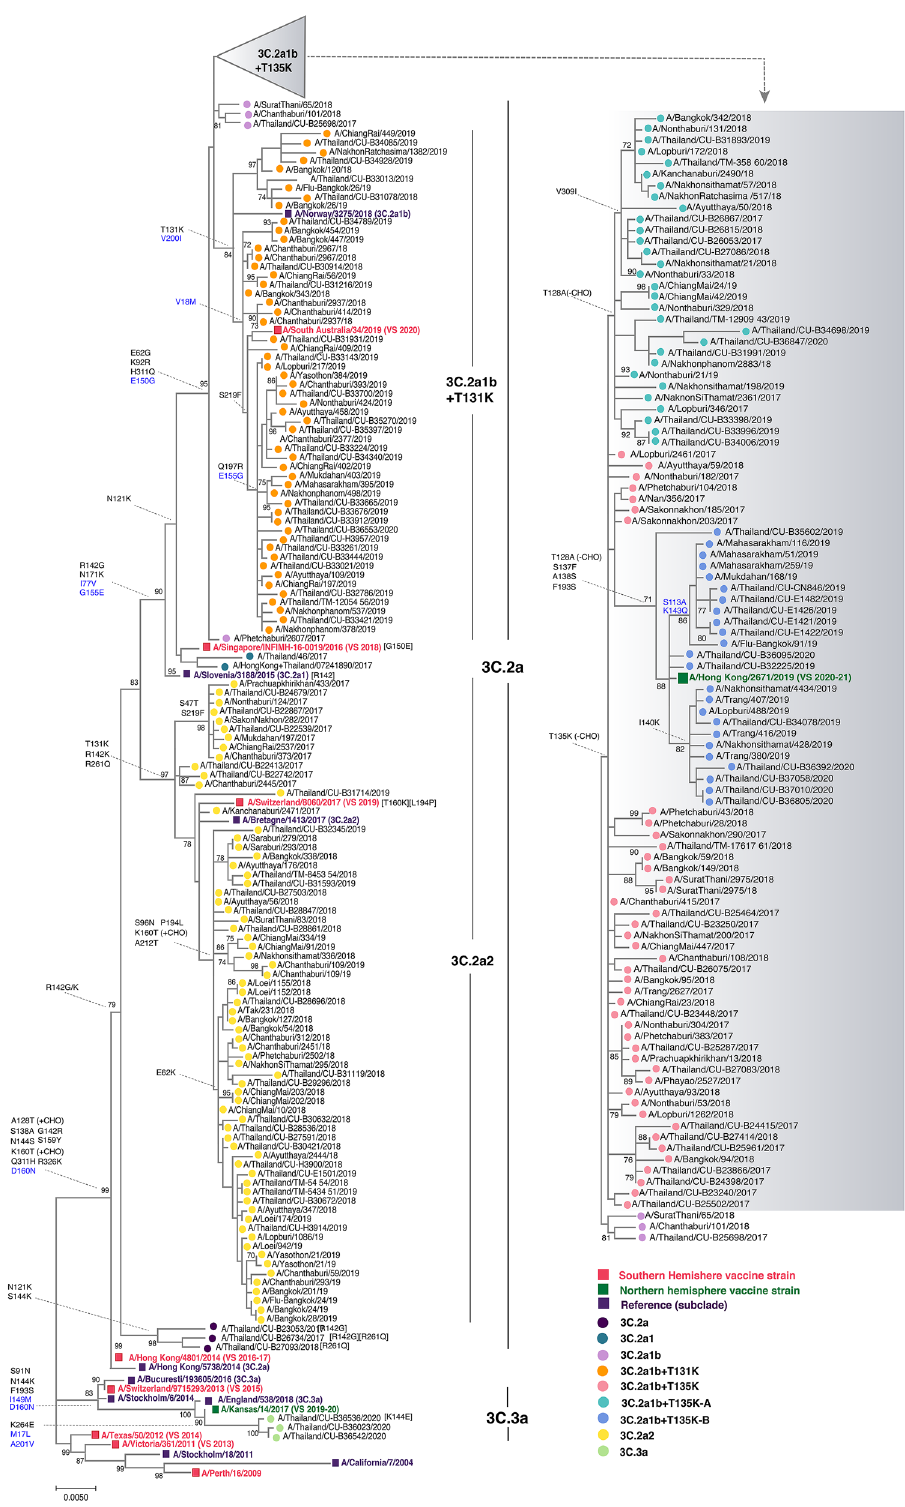
Figure 3. Phylogenetic analysis of the HA gene of A(H3N2). Sequences from 90 A/Thailand/CU strains and 142 other Thai strains available from the database were compared with the A(H3N2) vaccine and reference strains of known clades. Phylogenetic tree was constructed using the maximum-likelihood method using the HKY + G + I model with 1000 bootstrap replicates implemented in MEGAX. Branch values of > 70% are indicated at the nodes, along with the characteristic residues defining these branches. Residue changes in HA1 are denoted in black; changes in HA2 are in blue. Gain (+ CHO) and loss (−CHO) potential glycosylation sites were indicated. Southern hemisphere vaccine strains (magenta squares), the 2019–2021 northern hemisphere vaccine (green squares) and the reference strains (purple squares) are indicated. Colored circles denote the clade and subclade of A(H3N2) circulating strains. VS defined as vaccine